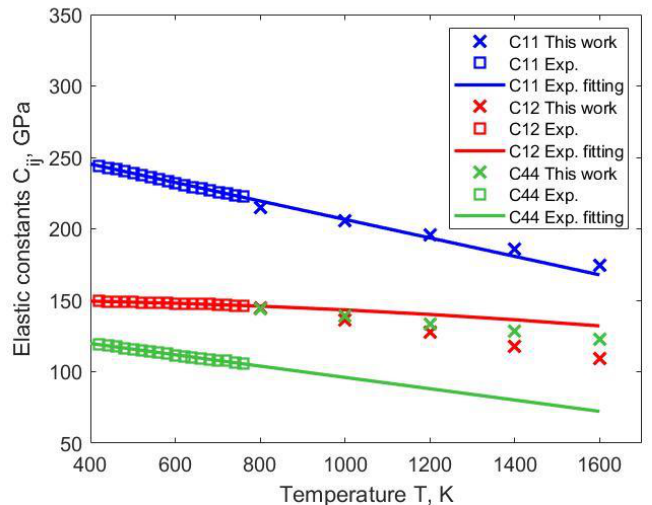
Figure 7. Temperature-dependent single elastic constants of paramagnetic nickel. Experimental data are from [48,52].